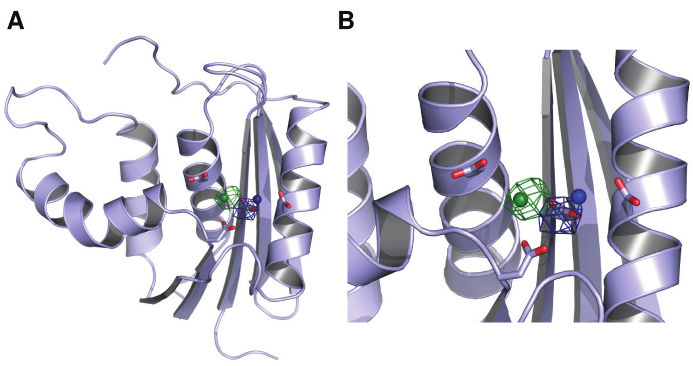
Figure 5. Mg 2+ ion dynamics in an ecRNH simulation initiated with single ions in the A and B sites. ( A ) Occupancy maps contoured at 10% occupancy for the A site (blue) and B site (green). Neither ion leaves the active site over the 100ns trajectory length. ( B ) Closer view of the active site in which the four active-site residues in apo ecRNH and the positions of the two Mn 2+ from which the trajectories were initiated (derived from PDB ID 1G15) are shown for